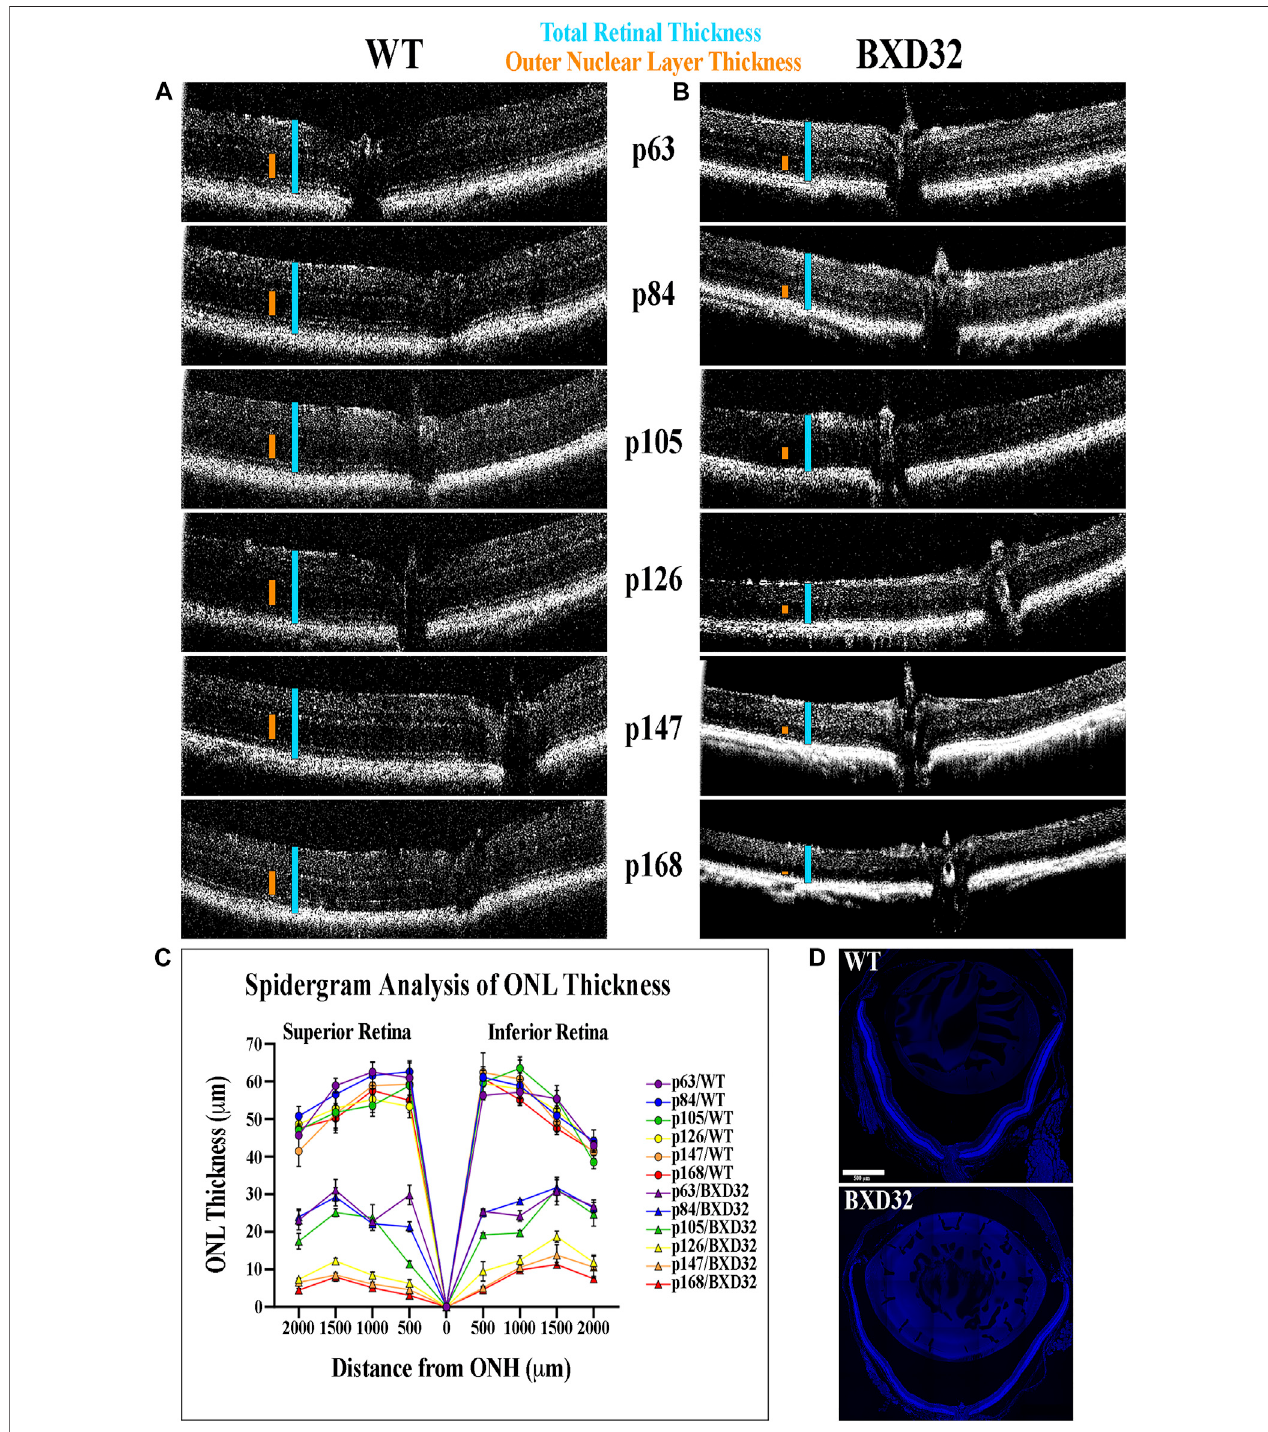
FIGURE 2 | BXD32 retinas degenerate rapidly when observed by OCT. WT (A) and BXD32 (B) mice were anesthetized and had their retinas imaged by OCT. p63 BXD32 mice already demonstrate thinning of both the ONL (orange caliper) and the total retina (light blue caliper) compared to WT. This thinning increases rapidly until almost no ONL exists by p168. (C) ONL measurements were taken from tiled DAPI stained retinal sections through the ONH at distances of 500, 1,000, 1,500, and 2000 μ m superiorly and inferiorly to the ONH and graphed as a spidergram. Examples of typical retinal tiled images are shown in (D) .